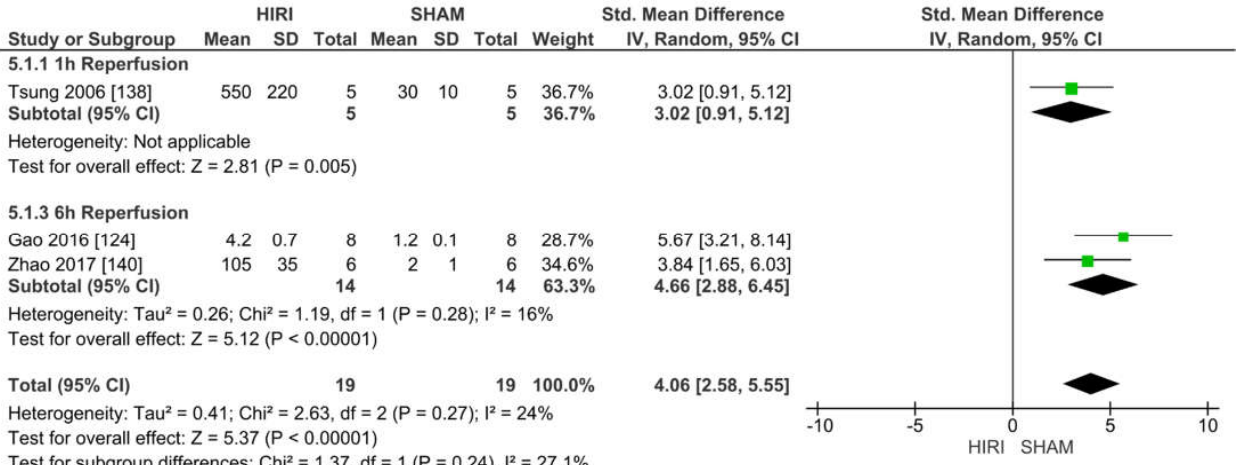
Figure 10. Forest plot of 100% HIRI in rats and 45 min warm ischaemia time grouped by reperfusion time between 0.75 and 24 h.